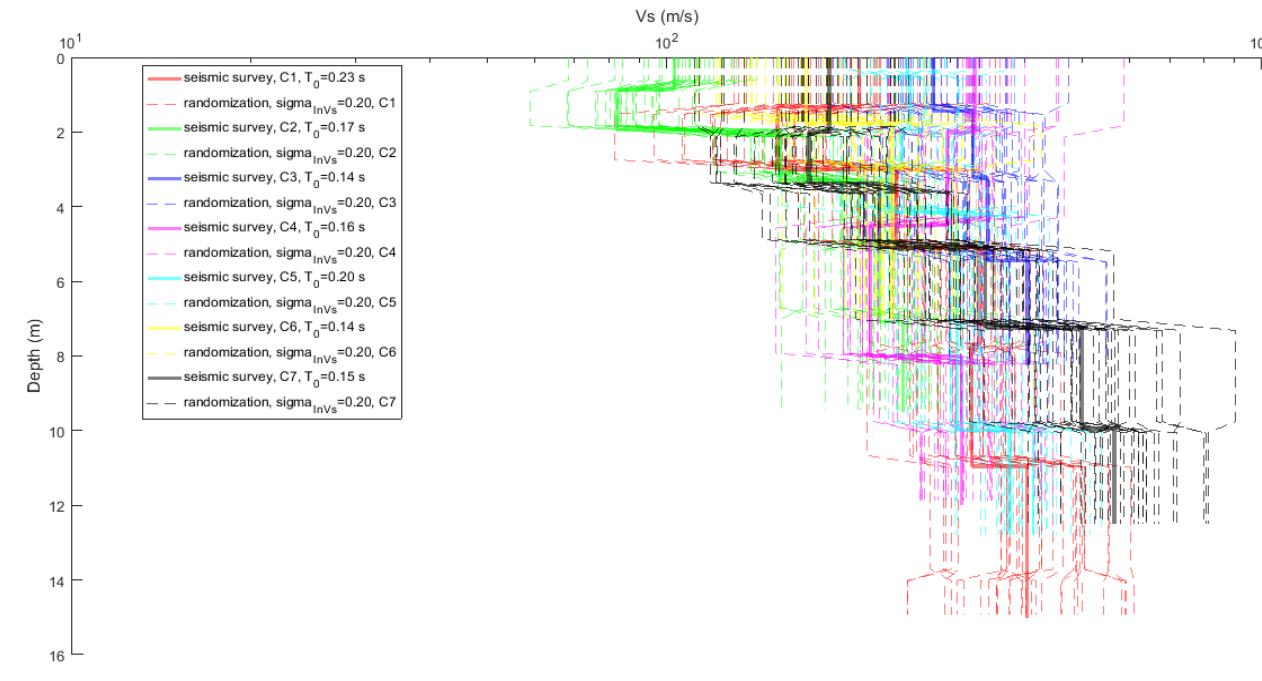
Figure 5. Randomized Vs profiles for sites C1 to C7. T 0 is the fundamental period of the site.